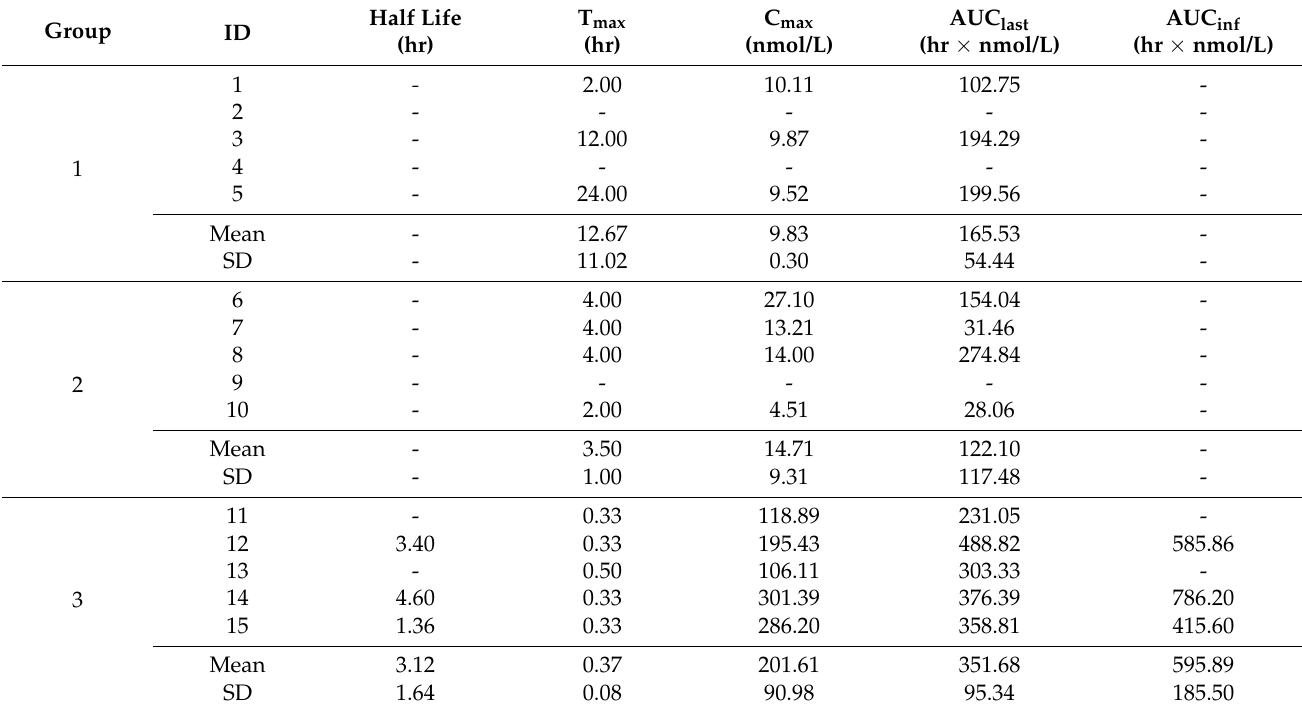
Table 4. The estimated pharmacokinetic parameters of